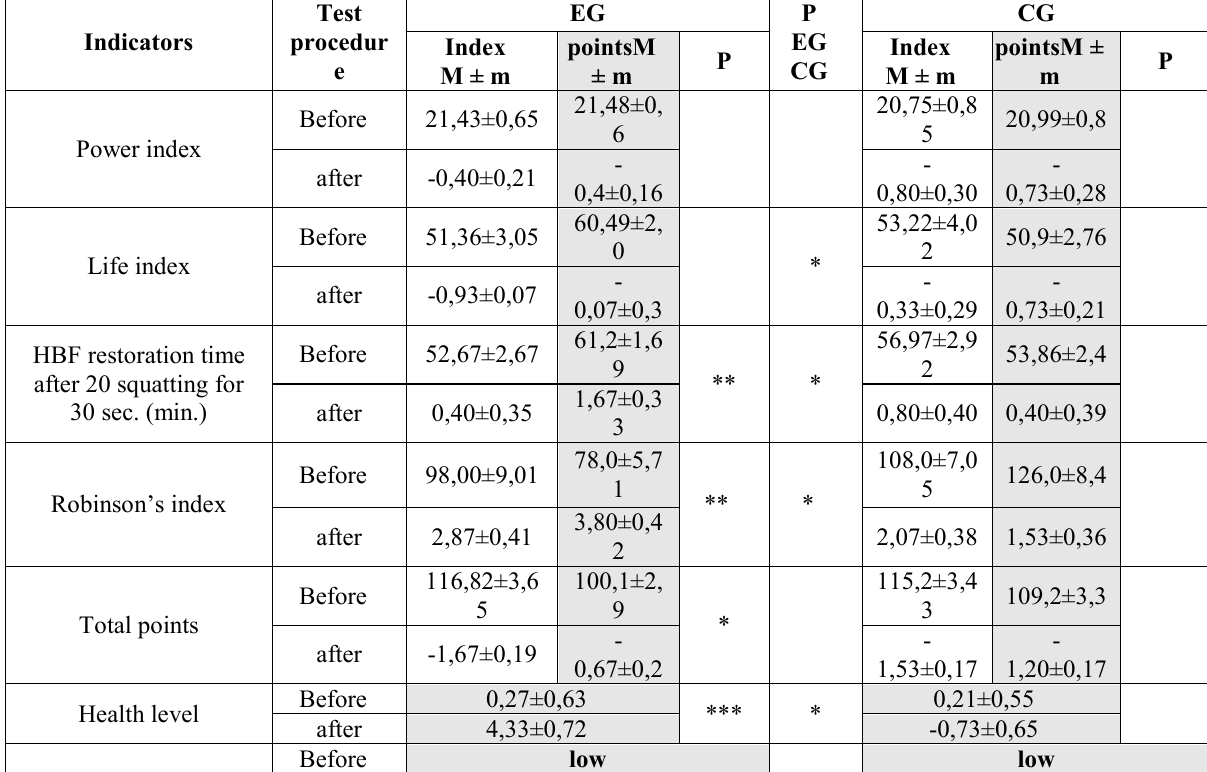
Evaluation of EG (n=15) and CG(n=15) boys somatic health before and after the second pedagogical